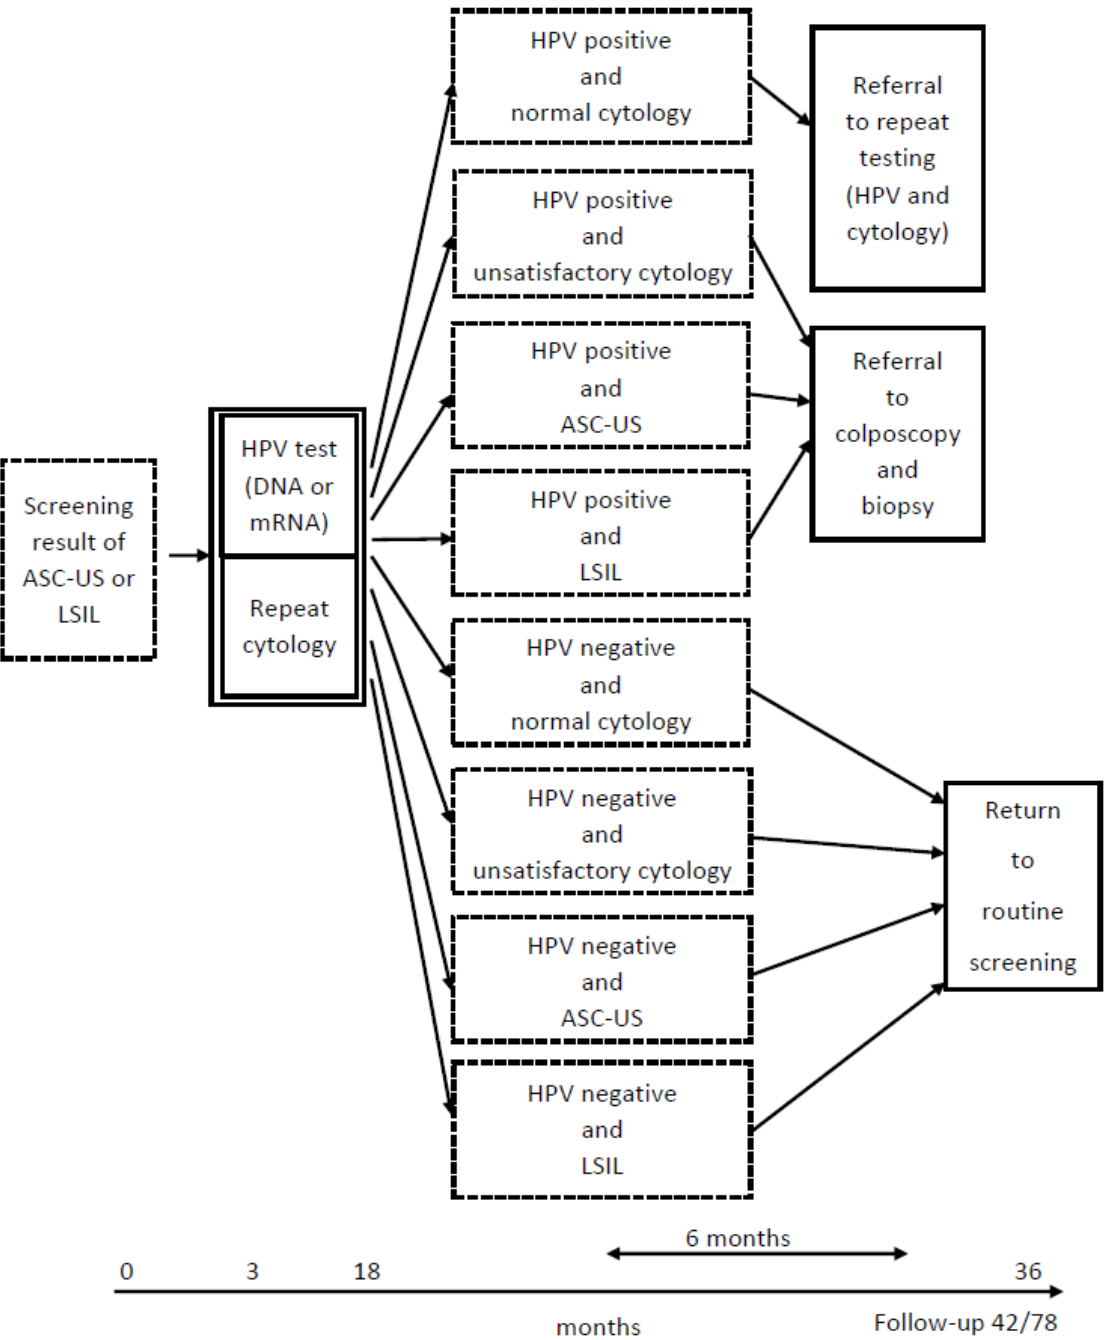
Figure 1. Screening algorithm in Norway during the study period. HPV, human papillomavirus; ASC-US, atypical squamous cells of undetermined significance; LSIL, low-grade squamous intraep- ithelial lesions; return to routine screening, return to the 3-year screening interval without further